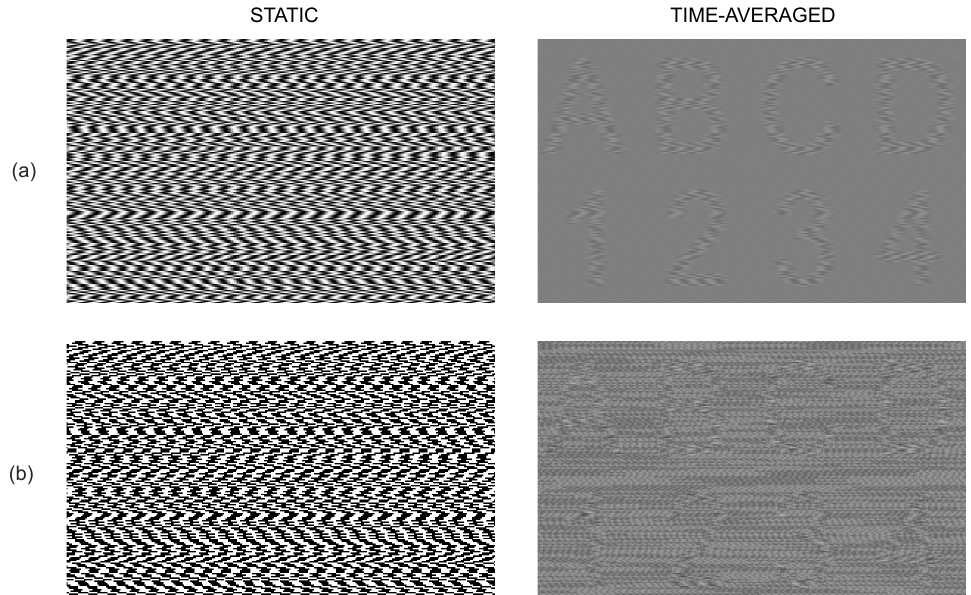
Figure 8. The stationary cover image and the decoded secret image produced by the different DVC schemes. The DVC scheme based on the harmonic moiré gratings is used to encode and decode the secret information in panel ( a ). The DVC scheme based on the dichotomous moiré gratings is depicted in panel ( b ).